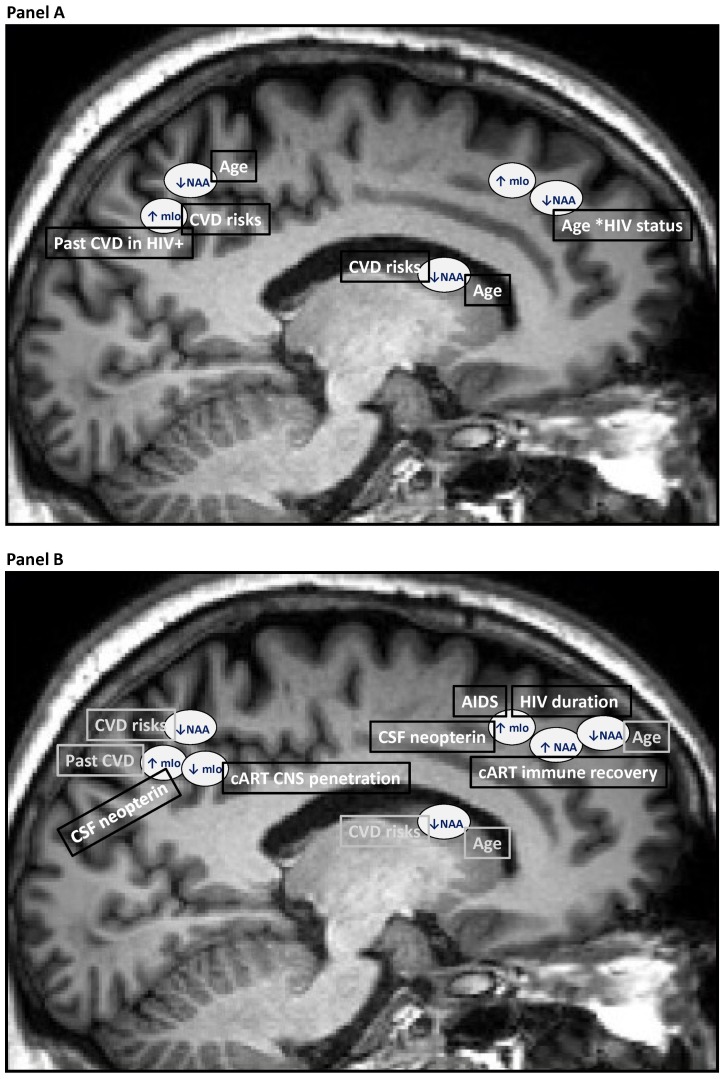
Age, CVD and HIV status predictors of brain moieties changes in the entire sample (panel A); Age, CVD, HIV biomarkers predictors of brain moieties changes in the HIV+ sample (panel B).